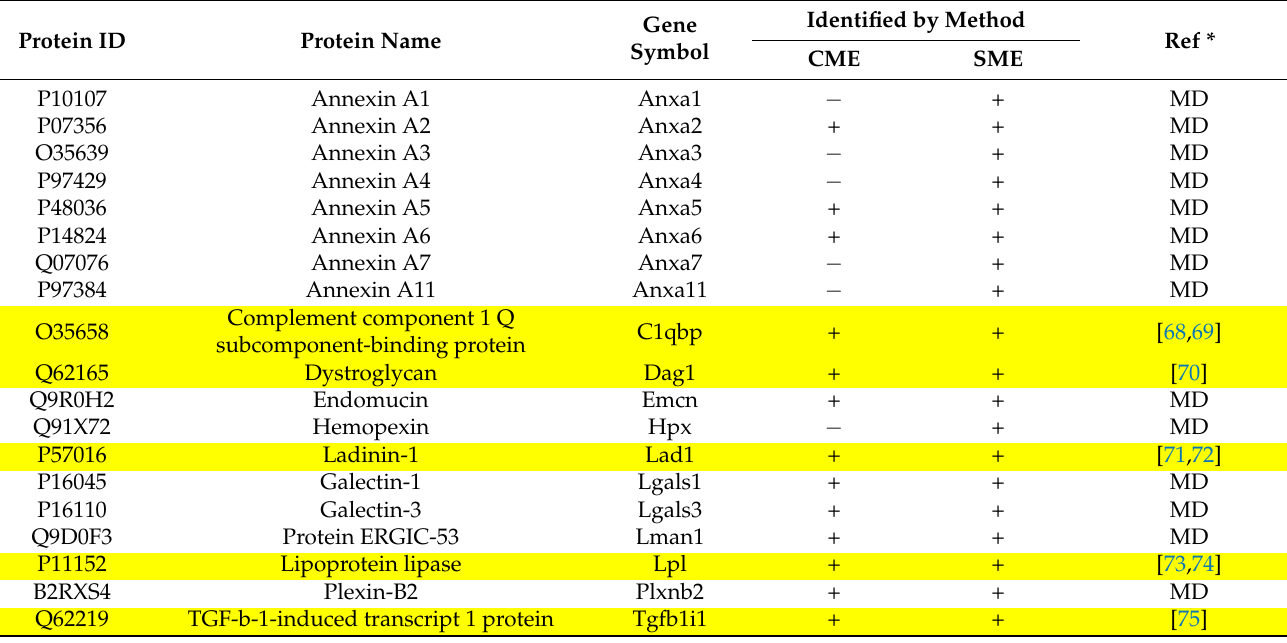
Table A5. The list of matrisome-associated proteins belonging to the category of ECM-affiliated proteins and identified in at least two of the biological replicates. Rows highlighted in yellow describe identified matrisome proteins which were not previously listed in the MD.